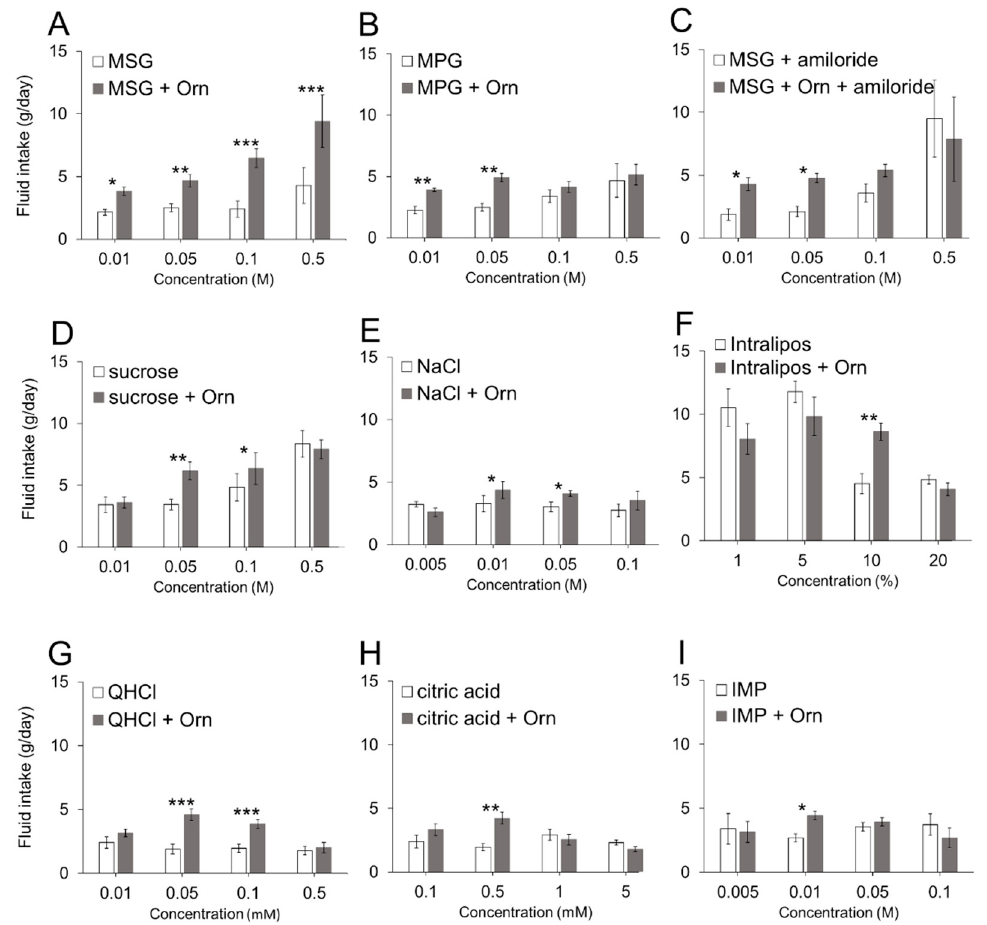
Figure 3. Additive effects of 1 mM L-ornithine (Orn) on different concentrations of taste solutions. Fluid intake (mean ± SE; n = 8) with and without Orn is shown for MSG ( A ), MPG ( B ), MSG with 0.01 mM amiloride ( C ), sucrose ( D ), NaCl ( E ), Intralipos ( F ), quinine hydrochloride (QHCl) ( G ), citric acid ( H ), and IMP ( I ). * p < 0.05, ** p < 0.01, *** p < 0.001.